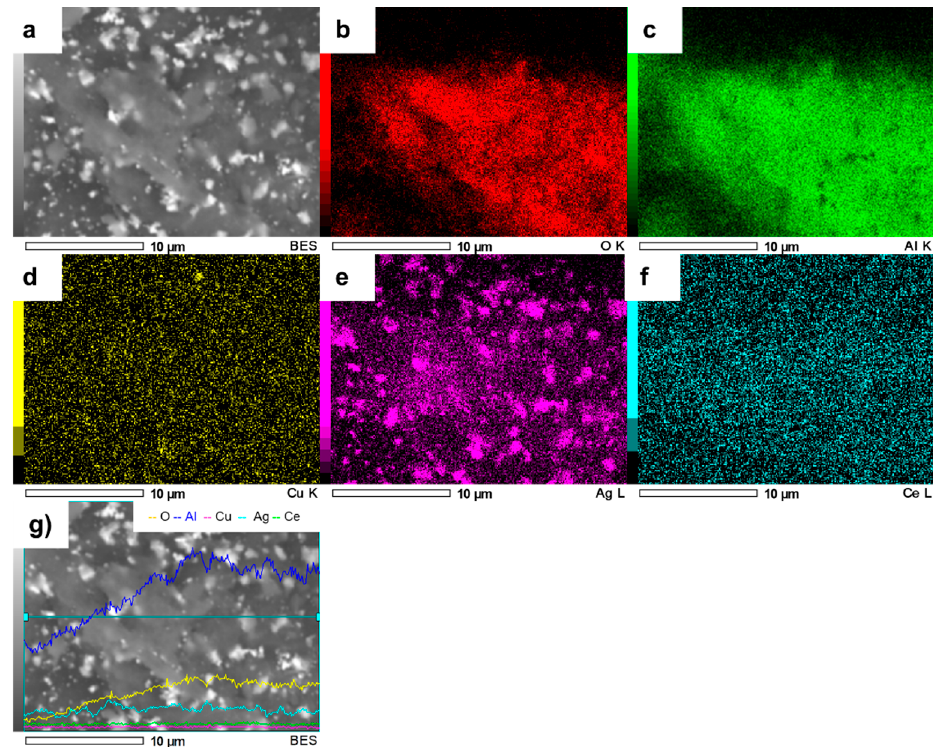
Figure 6. SEM image of AgCuAlCe ( a ) and the elemental mapping images of ( b ) O, ( c ) Al, ( d ) Cu, ( e ) Ag, ( f ) Ce and ( g ) EDS line scan of AgCuAlCe.